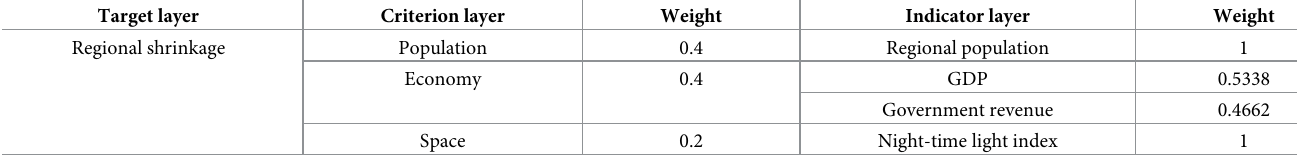
Table 1. Comprehensive evaluation indicator system for regional shrinkage of the three northeastern